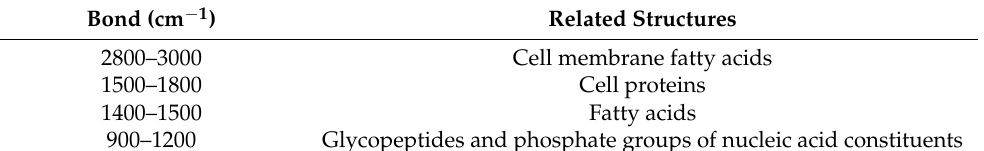
Table 2. Relationships between bonds and structure.